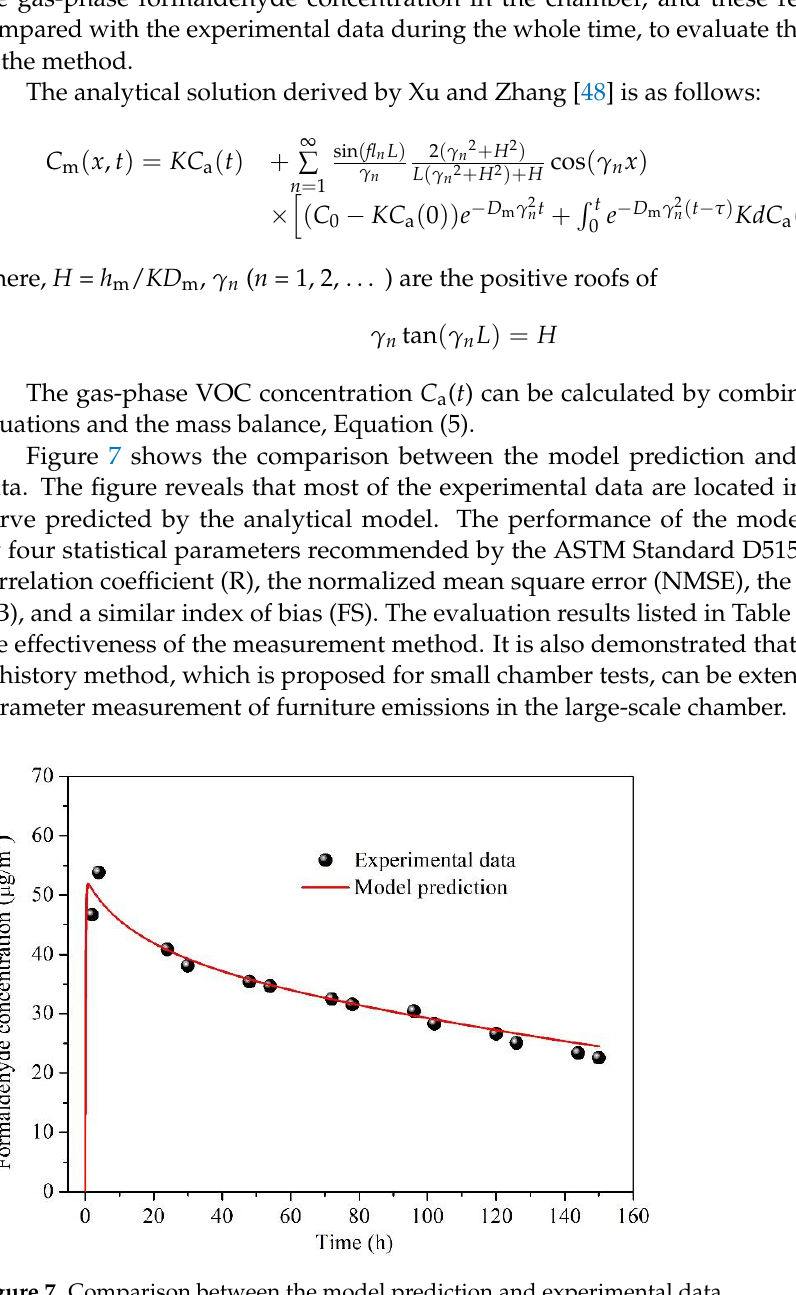
Figure 7. Comparison between the model prediction and experimental data.